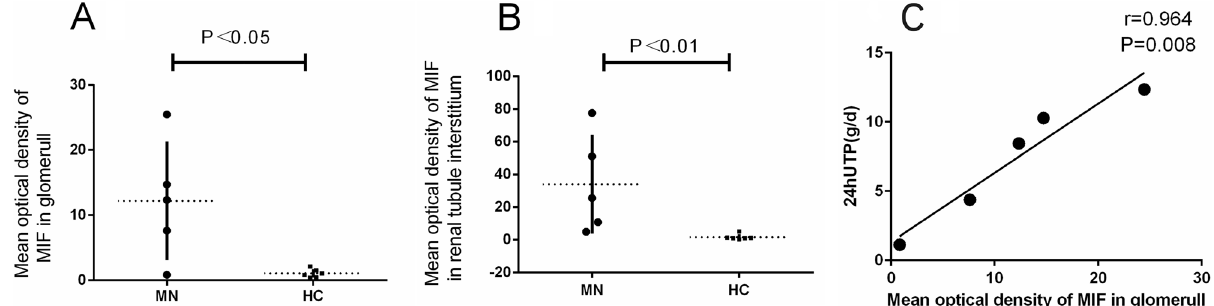
Figure 5. Comparison of MIF expression levels of kidney tissues in MN patients and controls. ( A ) Comparison of MIF expression levels in the glomeruli between MN patients and controls, P < 0.05. ( B ) Comparison of MIF expression levels in the tubular stromal region of MN patients and controls, P < 0.01. ( C ) Correlation between glomerular MIF expression and UTP/24 h: glomerular MIF expression in MN patients (r = 0.964, P =